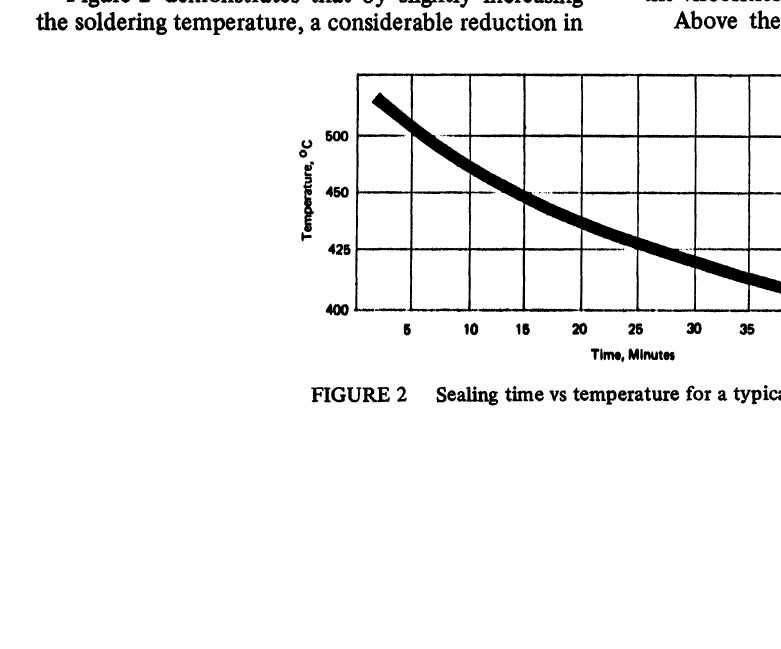
-- O Strain Point O "O Anneal Point Softe.lng Solder Glass /--- Glass Work Piece Temperature oc FIGURE Viscosity-temperature relationship of solder glass and work FIGURE 2 Sealg time vs temperature for yp solde